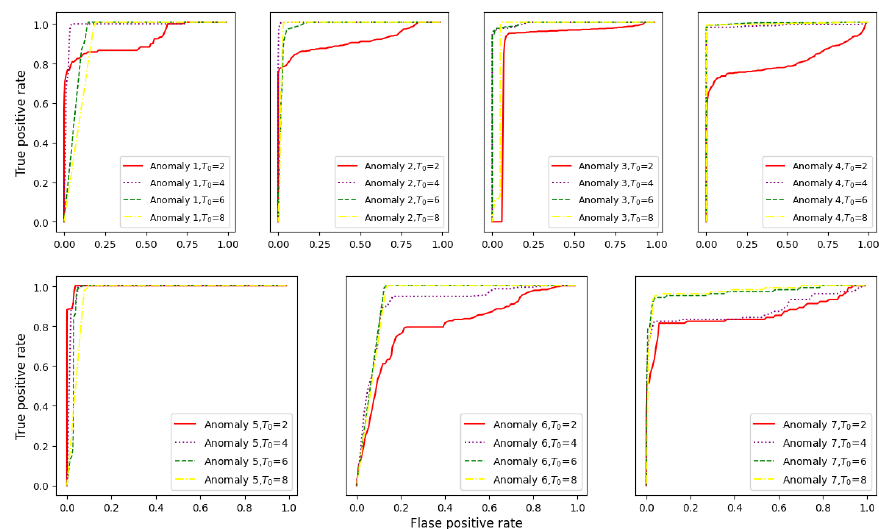
Figure 10. ROC curves for SFAD with different values of T 0 ∈ { 2, 4, 6, 8 } .